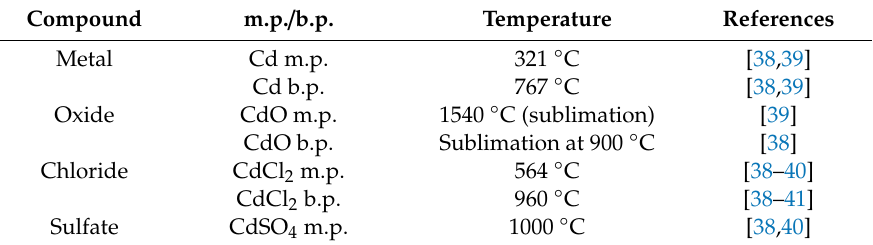
Table 2. Melting points (m.p.) and boiling points (b.p.) of Cd and its target compounds. Compound